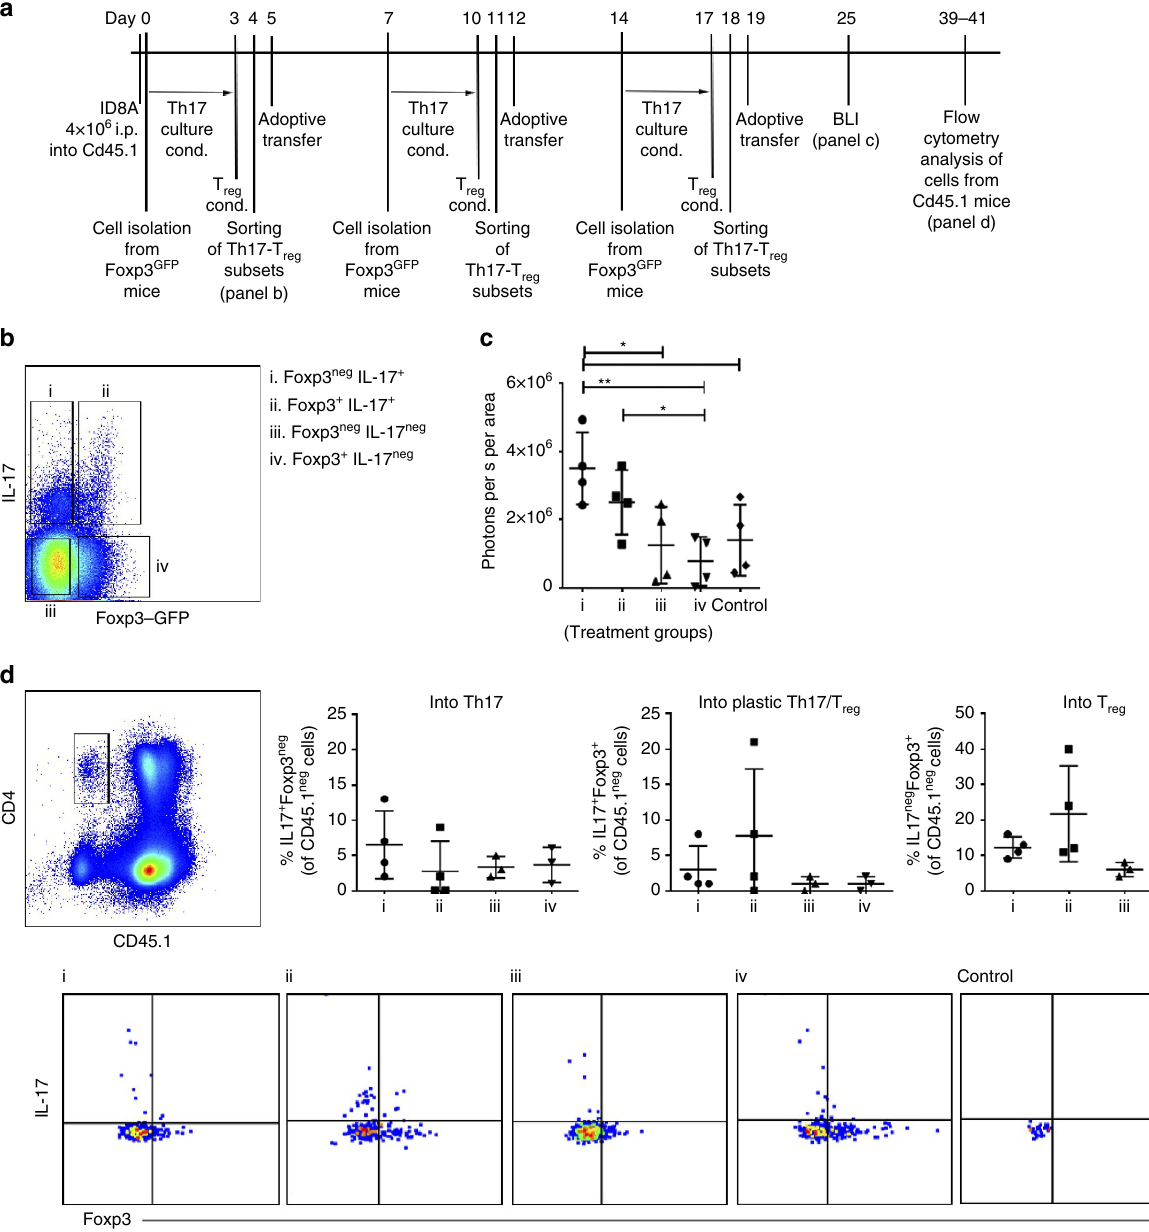
IL-17A þ Foxp3 neg